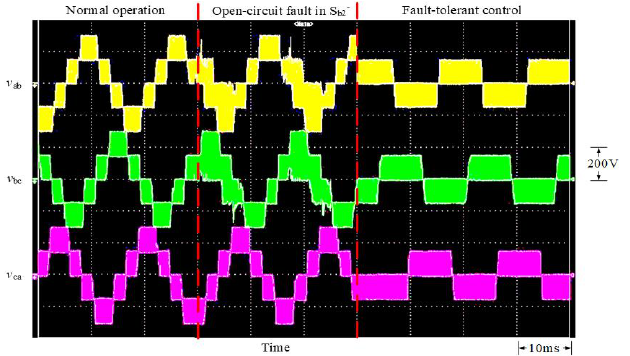
Figure 23. Measured waveform of the output voltage generated by the fault-tolerant control strategy when an open-circuit fault occurs in the switch S b 2- .